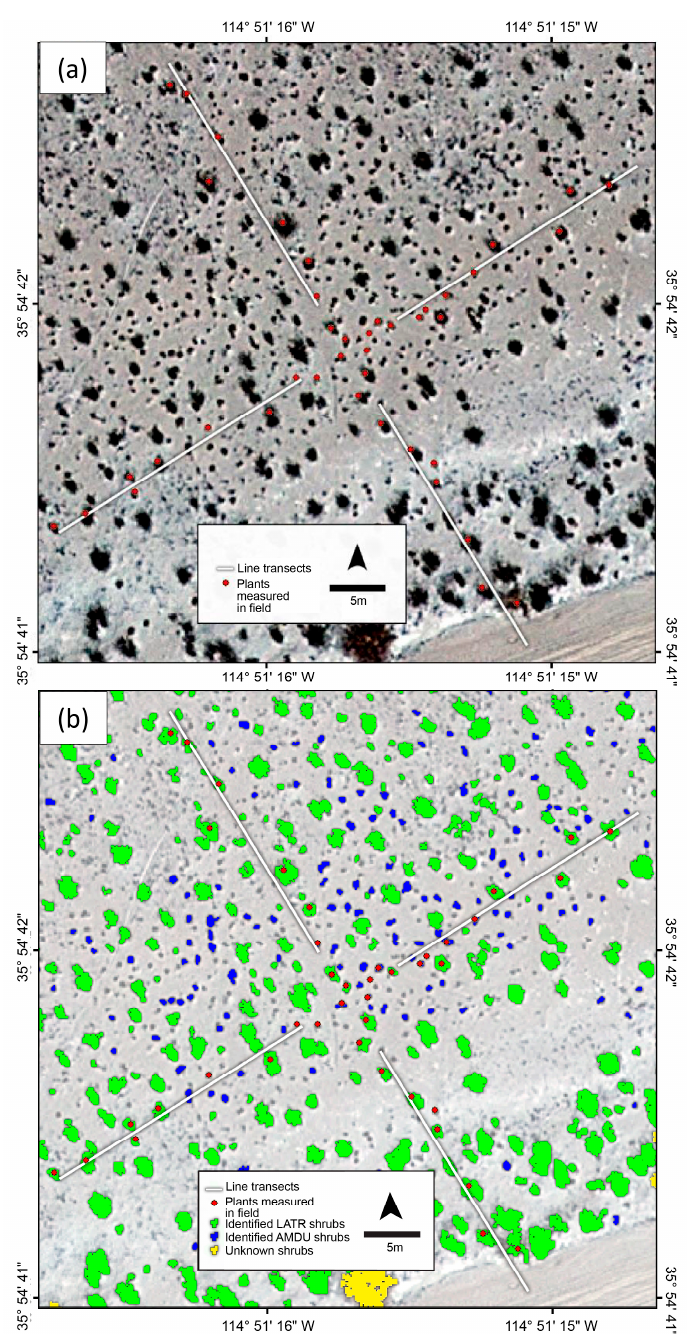
Figure 4. ( a ) Observed and ( b ) predicted shrubs for Site #2, used as an example of other sites. White bars represent line transect locations; red dots represent plants measured in the field; green shapes represent LATR shrubs; and blue shapes represent AMDU shrubs, as identified by the